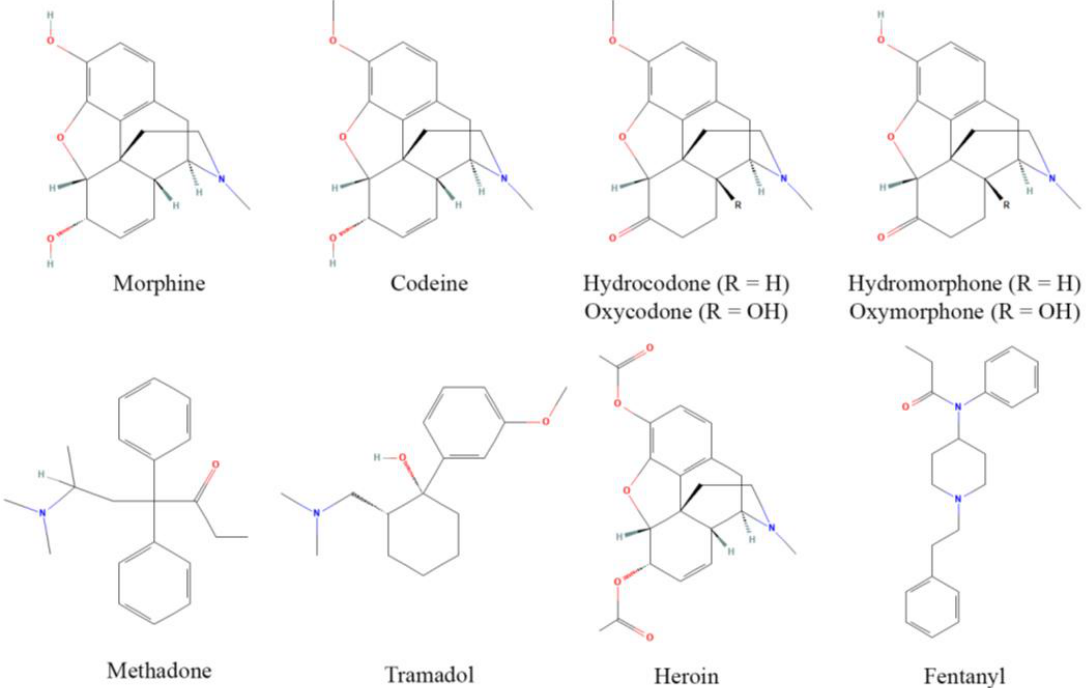
Figure 1. Structures of common opioids. Some prominent clinical opioids include morphine, codeine, hydrocodone, oxycodone, hydromorphone, oxymorphone, methadone, and tramadol, while heroin and fentanyl are most often subject to illicit use. Structures are derived from [35].